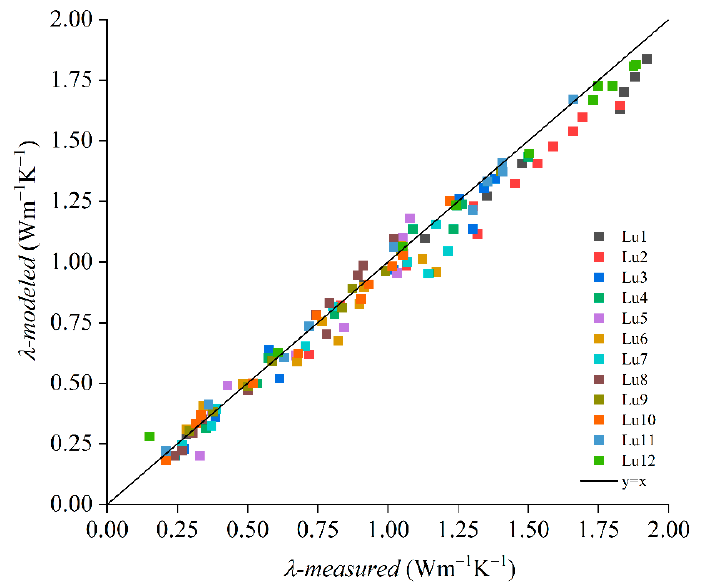
Figure 6. Comparison of soil thermal conductivity predicted from the revised model vs. measured values.